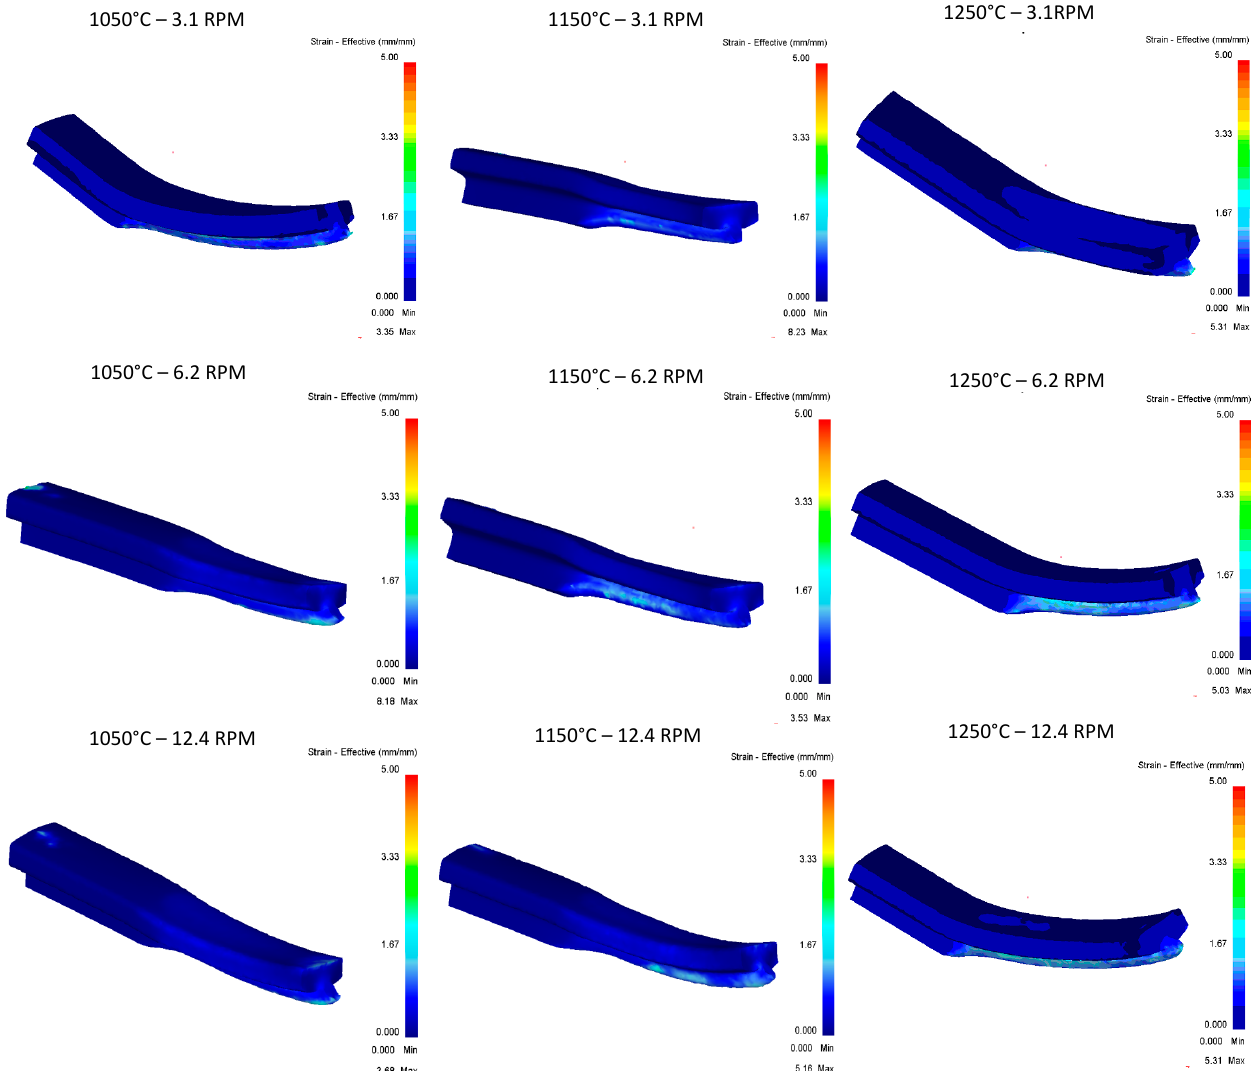
Figure 11. Effective strain in the top rail after first pass.